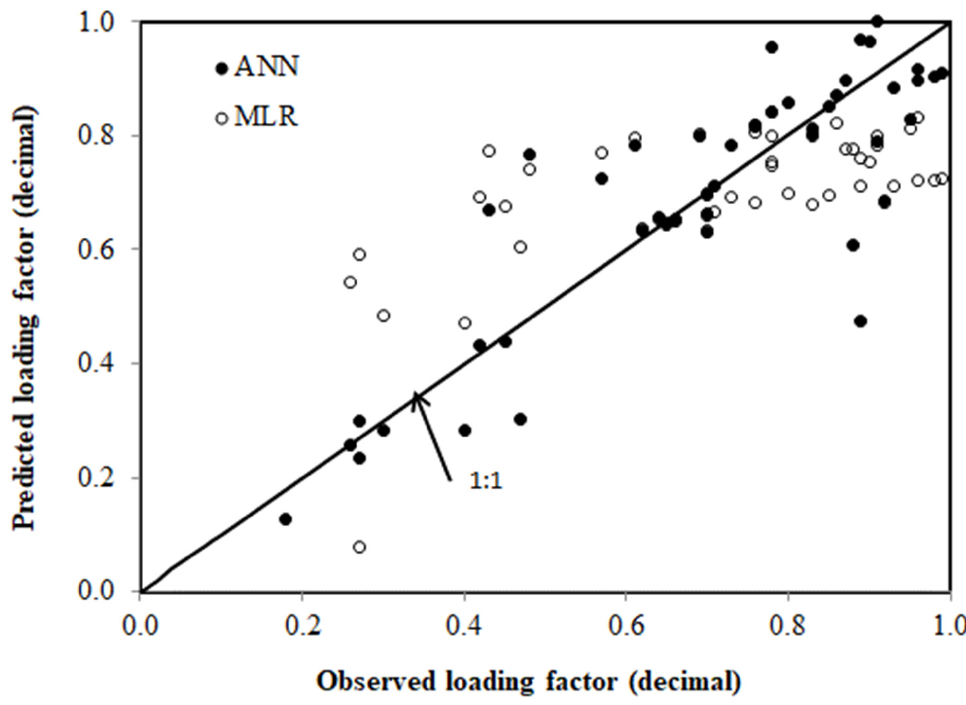
Figure 11. Correlation between the observed and predicted values for the loading factor of the MLR and ANN models in the case of the testing dataset.